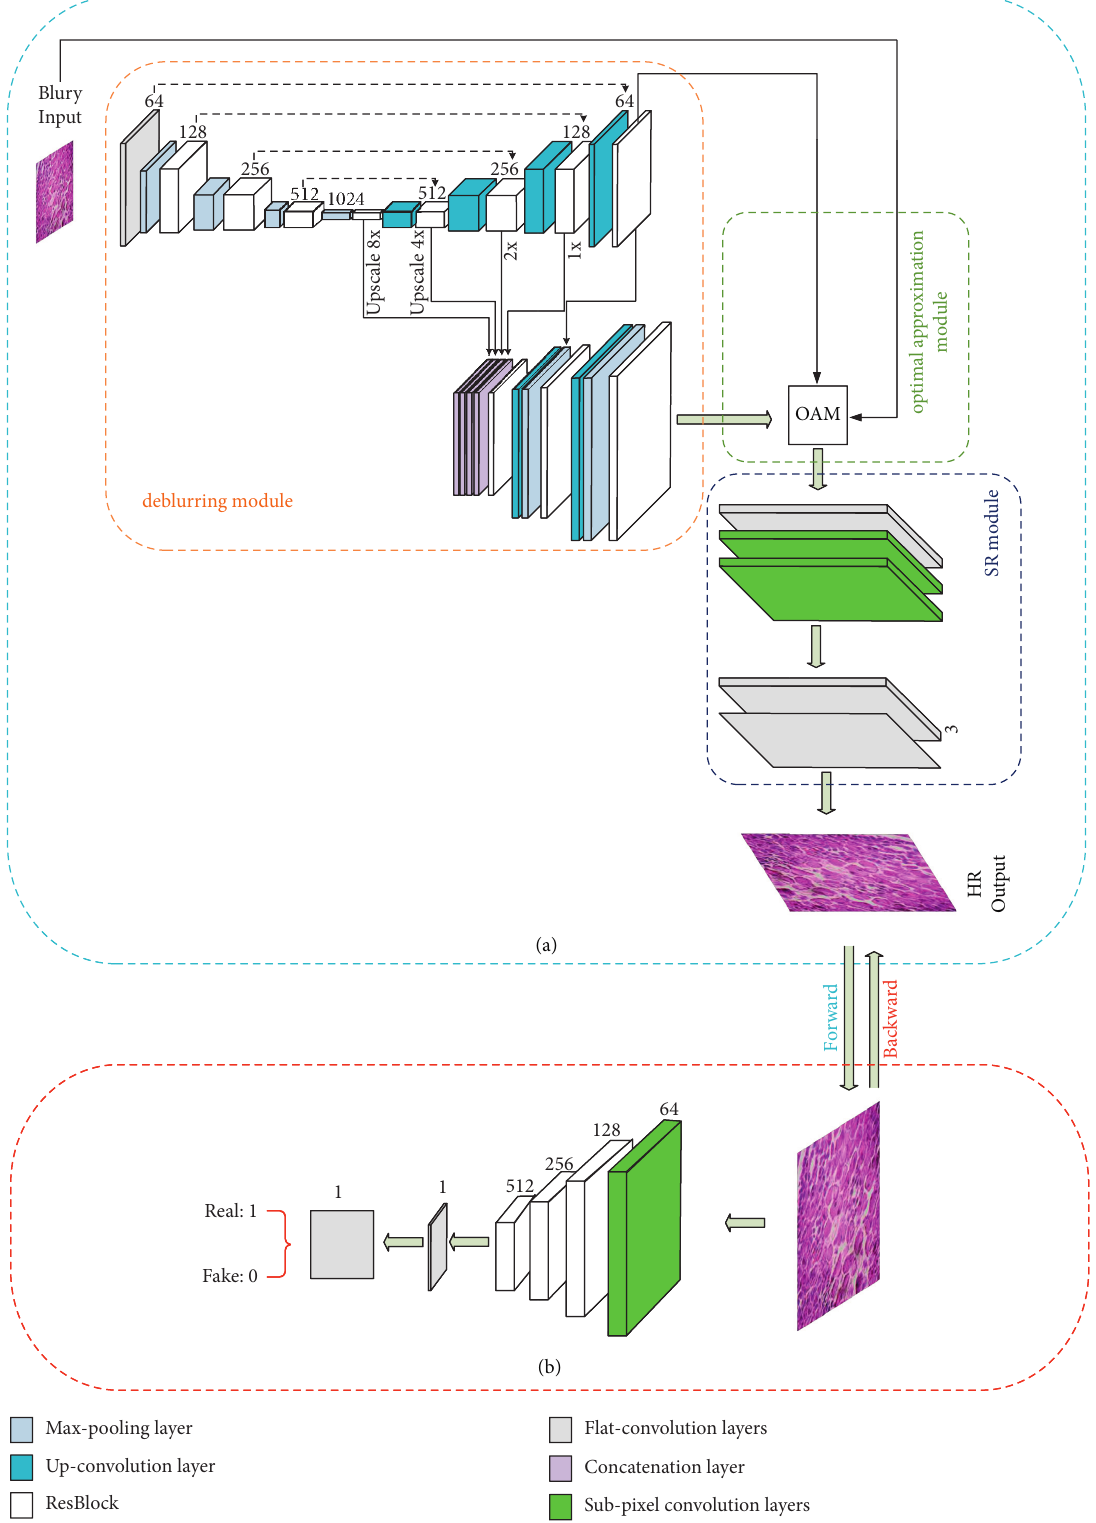
Figure 1: M-Deblurgan pipeline architecture. (a) Generator network. (b) Discriminator